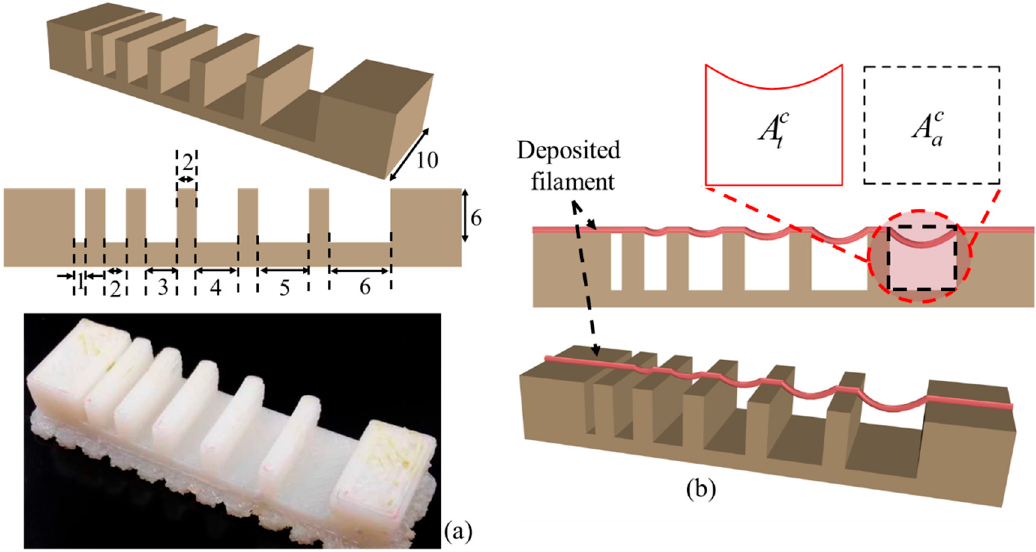
Figure 5. ( a ) Model and fabricated part of the platform; ( b ) Determination of collapse area factor.